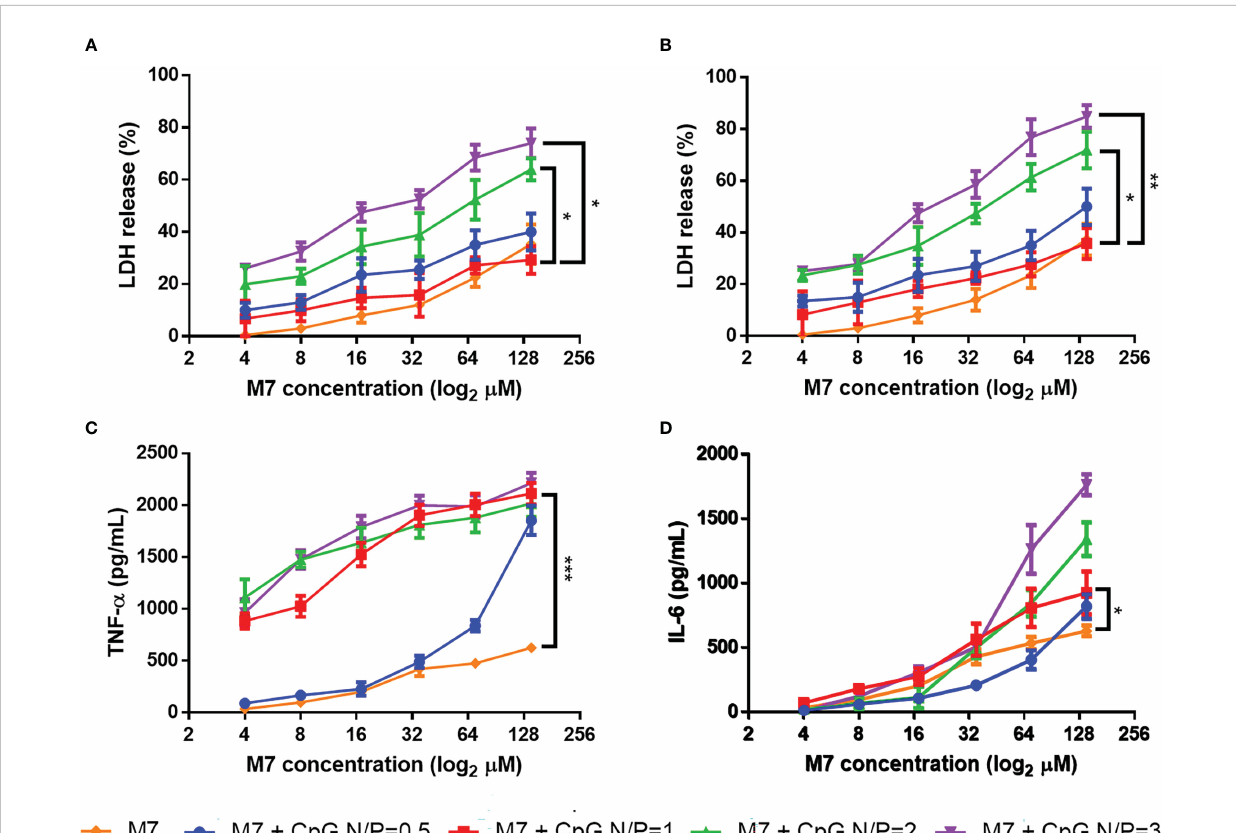
FIGURE 1 M7 and CpG combined at an N/P ratio = 1 induce the lowest cytotoxicity and the best proin fl ammatory cytokine release. M7 was mixed at different nitrogen/phosphate (N/P) ratios with CpG and cultured with DC2.4 cells at different dilutions. Cytotoxicity was measured through LDH release at (A) 24 h and (B) 48 h post-stimulation. (C) TNF- a and (D) IL-6 expression in culture supernatants were evaluated at 48 h post-stimulation ( n = 6, two independent experiments). Data are presented as mean ± range. Signi fi cant differences were determined using a two-way ANOVA test with Tukey ’ s multiple comparison (* p -value ≤ 0.05; * p -value ≤ 0.01; *** p -value ≤